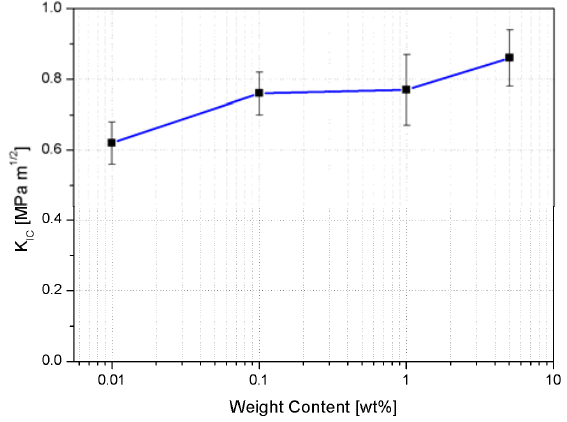
Figure 13. K IC results obtained from fracture toughness tests for neat and filled systems.